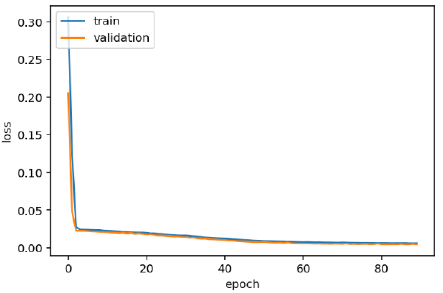
Figure 8. Model loss of training and test datasets. Figure 9 represents the correctness of the prediction of test and training datasets. The plot indicates the real values on the abscissae and predicted values on the ordinates. Thus, the best scenario is when the observations are on the diagonal of the plot. This plot shows that the model better predicted high depths (>0.5 scaled values) than small depths.